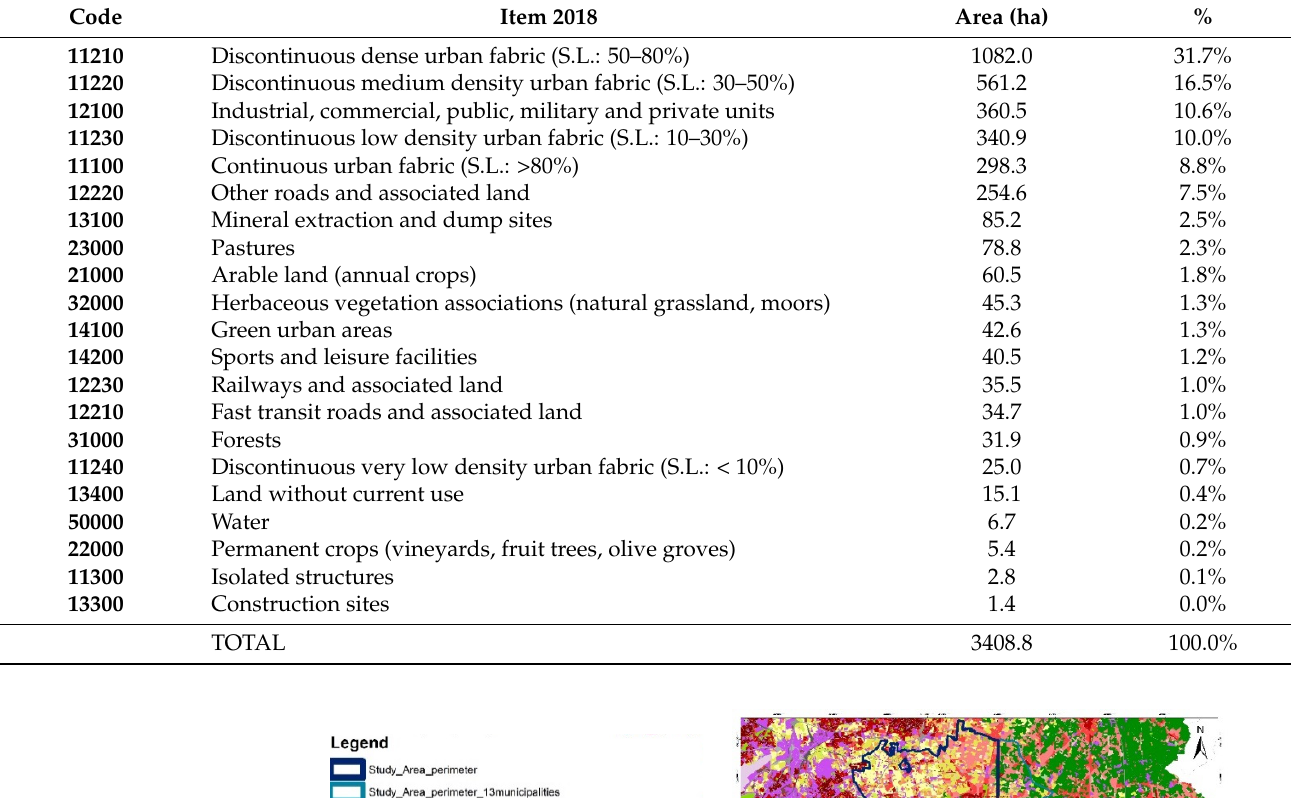
Table 11. Urban Atlas (2018) land uses in urban expansion areas between 1960–2009.